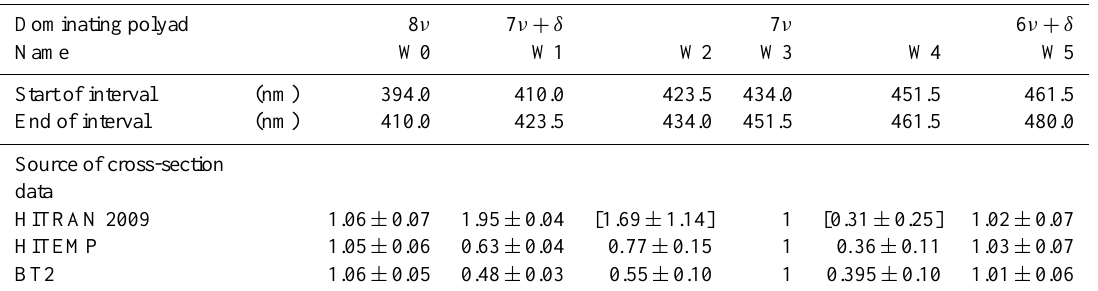
Table 9. Correction factors for HITRAN 2009, HITEMP and BT2, calculated as error-weighted means of the values derived from MAX- DOAS and LP-DOAS observations listed in Table 5 relative to W3. Values listed in square brackets in Table 5 were not used. When both values in Table 5 are above a relative fit error of 25%, only the MAX-DOAS values are used and listed in square brackets. The relative error for each of these values listed in Table 5 was estimated to be twice the fit error listed in Table